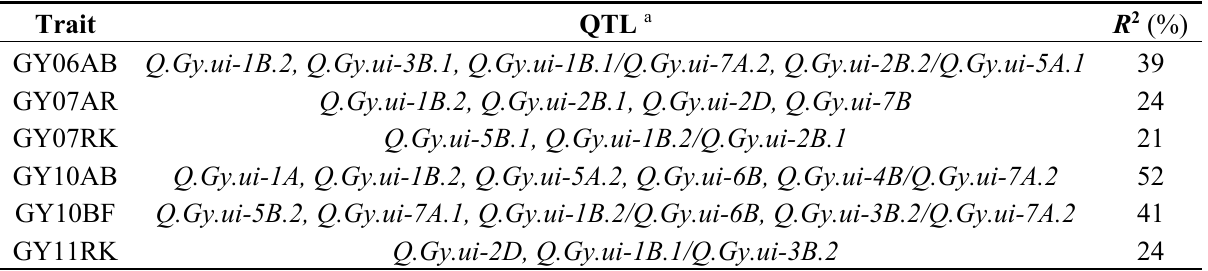
Table 9. Total phenotypic variation ( R 2 ) of grain yield explained by QTL main effect and interaction